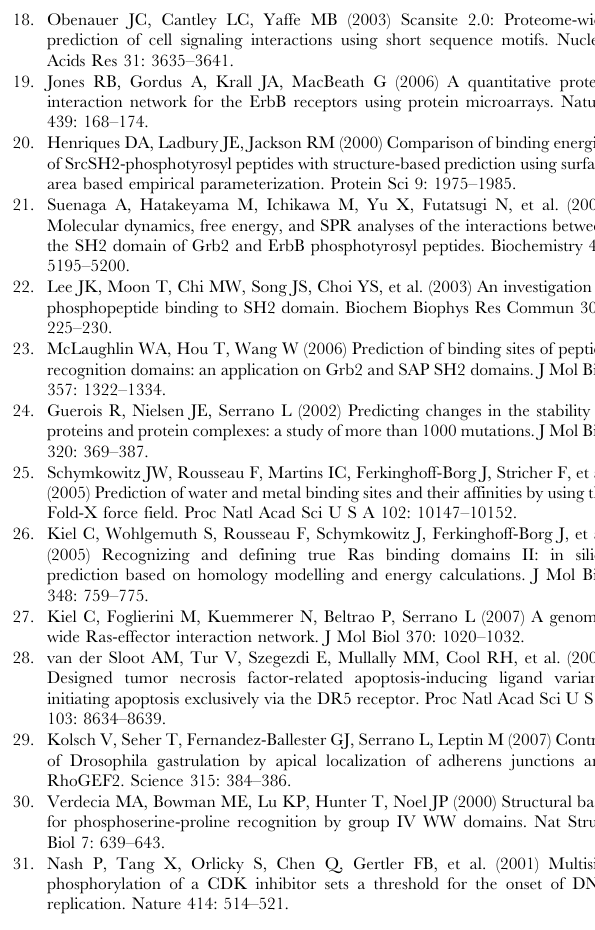
Table S1 Experimental and calculated changes in free energy for protein-phosphopeptide complex formation upon dephosphor- ylation. Table S2 Experimental and calculated changes in free energy for protein-phosphopeptide complex formation for mutations in the environment of the phosphate group in protein-phosphopep- tide complexes.